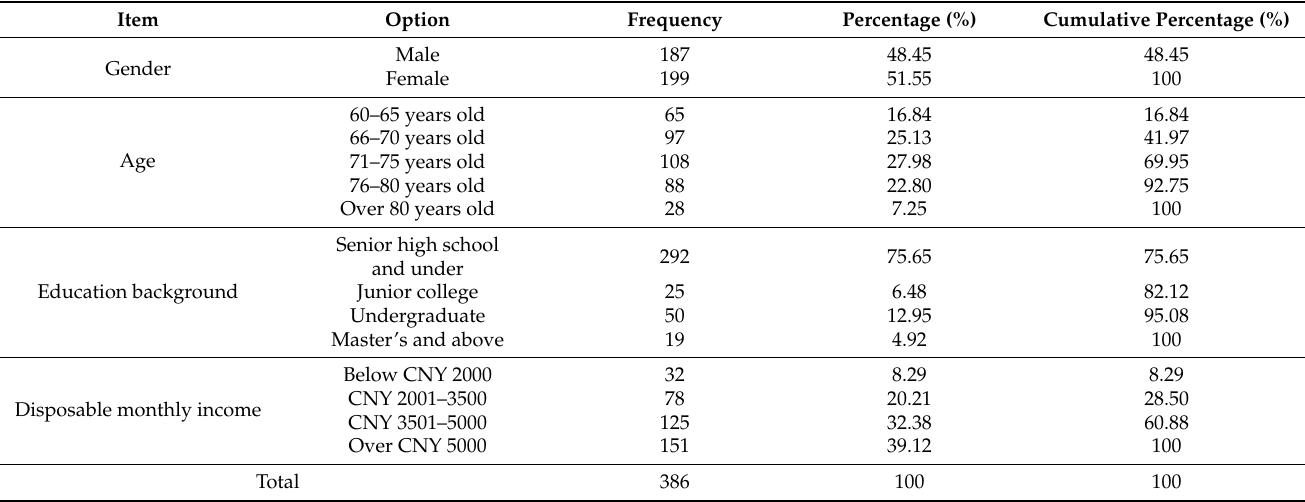
Table 3. Basic information of